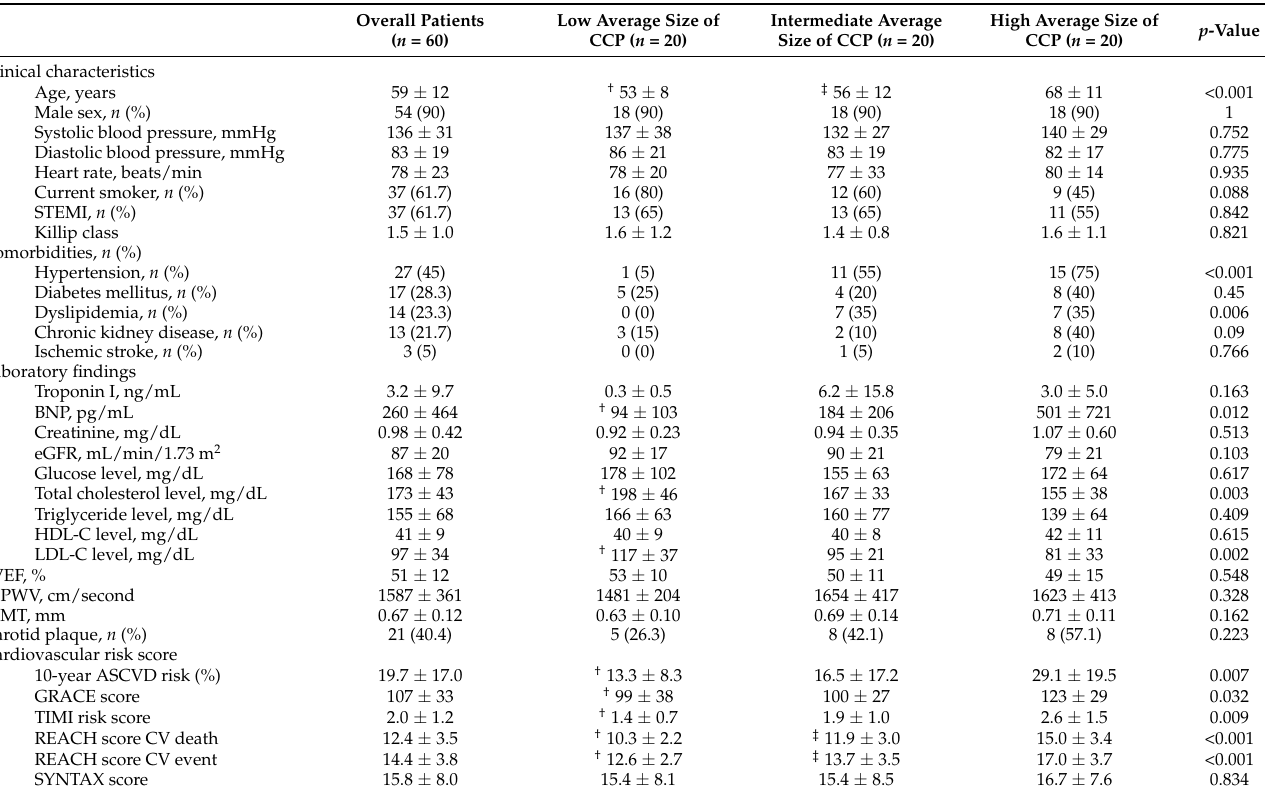
Table 2. Baseline characteristics in the three groups according to the average size of choriocapillaris measured by OCTA. Overall Patients ( n =